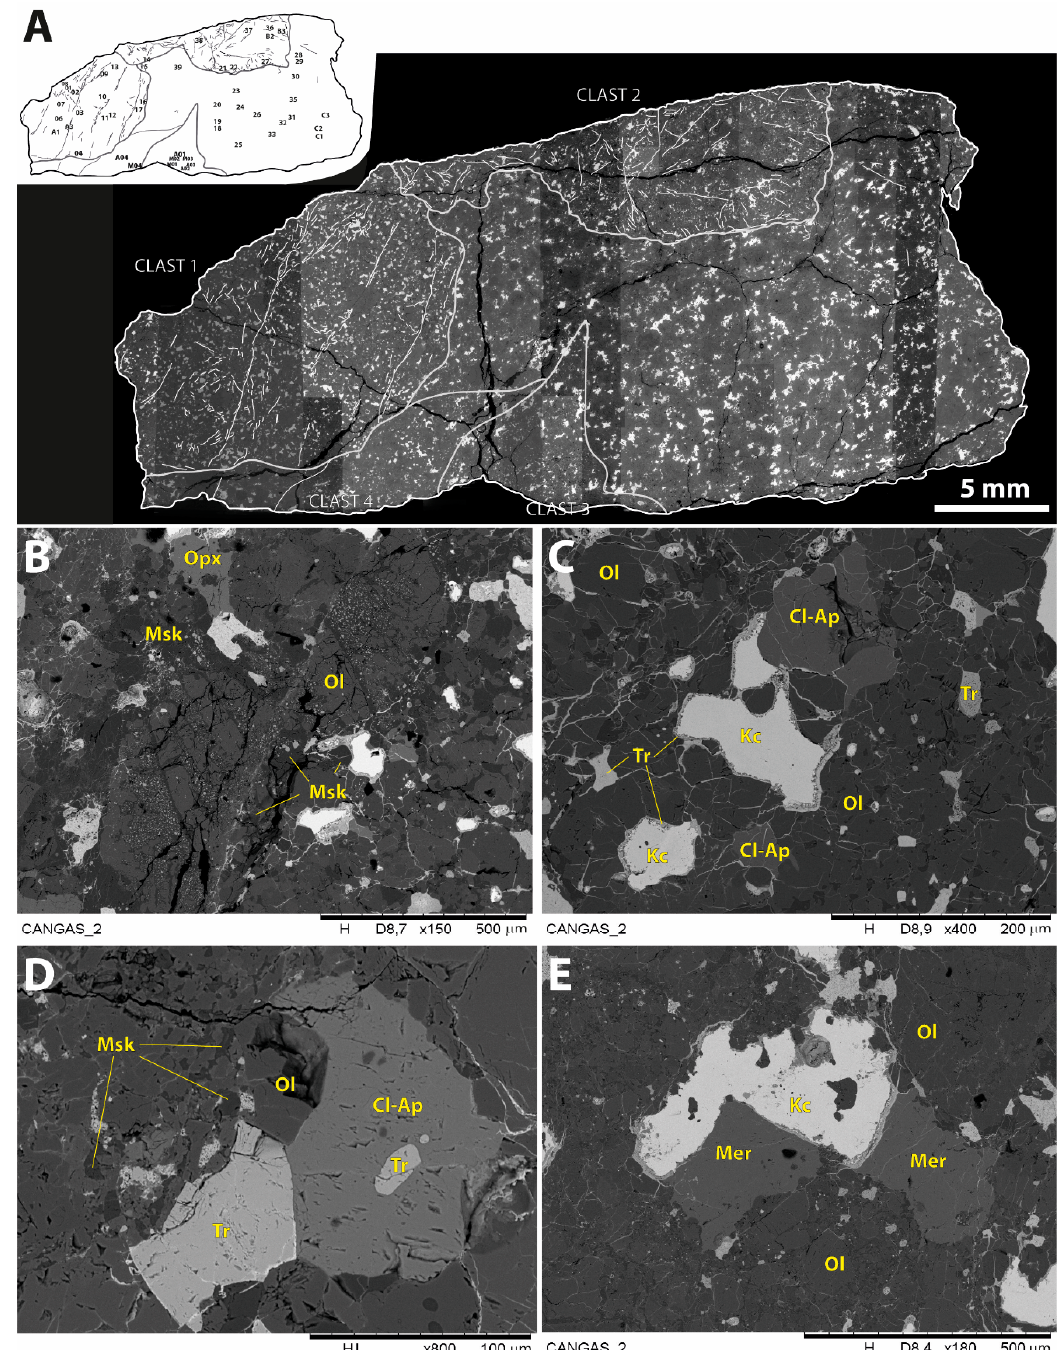
Figure 1. Scanning electron images of the sample ( A ) Image photomontage of the analyzed sample surface. Position of analyzed fields and main clasts are schematized in the upper left inset. ( B ) Shock-melted fracture in field 17 (Clast 1), affecting an olivine chondrule. ( C ) Textural features of analyzed phosphates in Clast 3 (field A04). ( D ) Chlorapatite in Clast 2 (field 38). ( E ) Merrillite over kamacite partially affected by shocked veins of troilite. Opx: Orthopyroxene; Msk: Maskelynite; Ol: Olivine; Tr: Troilite; Kc: Kamacite; Mer: Merrillite; Cl-Ap: Clorapatite.